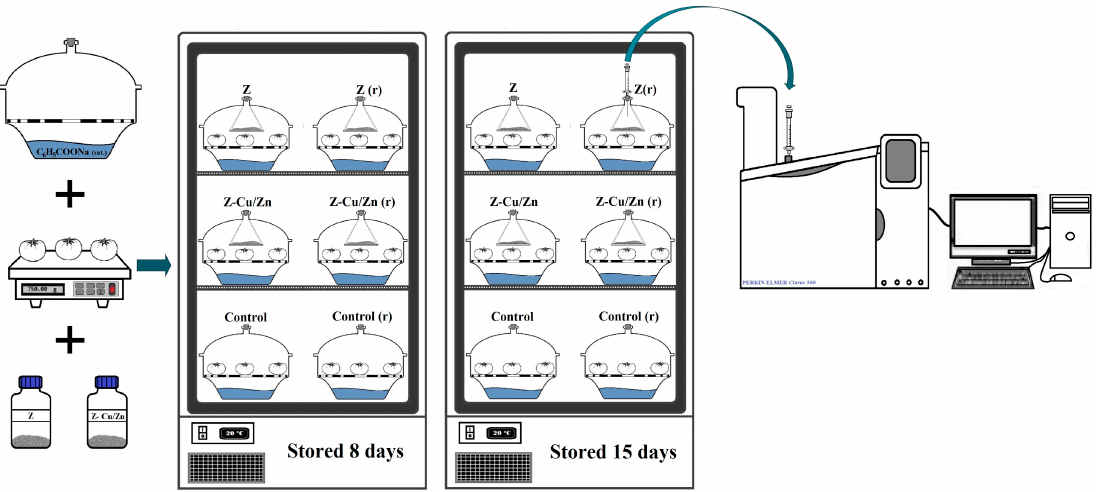
Figure 2. Schematic experimental setup for tomato storage over time for different treatments.